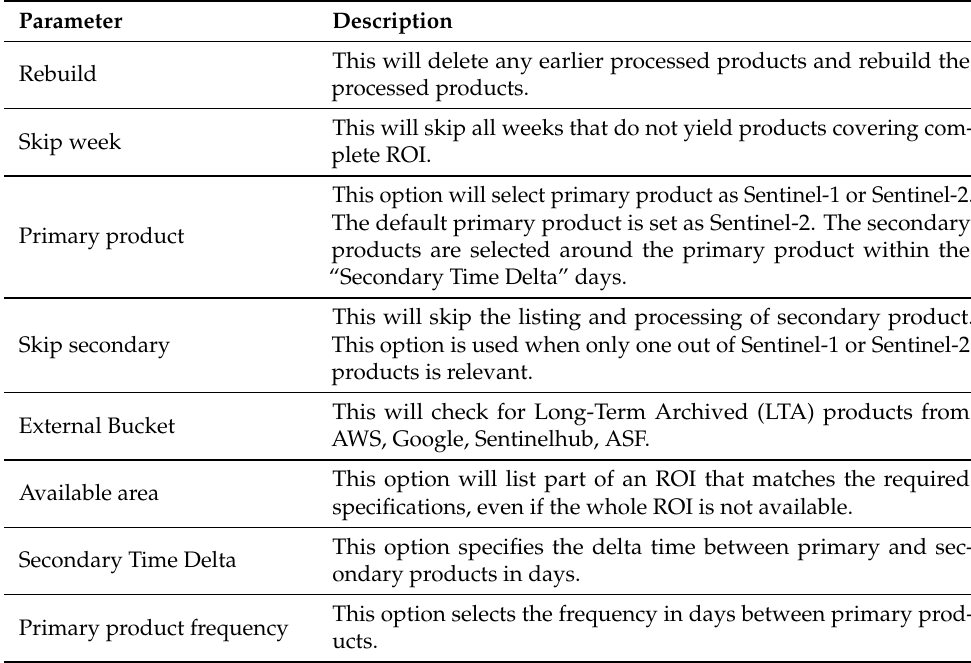
Table A2. Parameters used for ARD framework